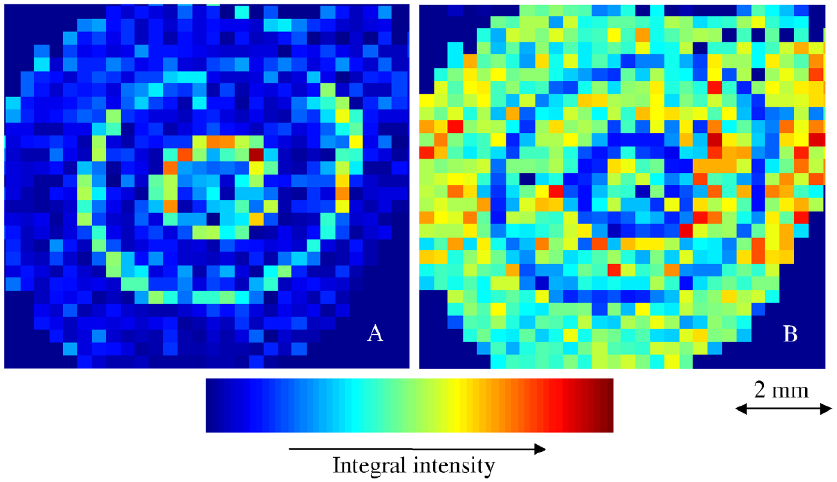
Figure 4. Chemical images of the cross-sectioned urinary stone constructed prior to performing the KKT : A – MIR image of calcium oxalate (C-O) at 1318 cm -1 ); B – MIR image of uric acid (integrated band - n (integrated band - n as oxalate (integrated band - γ (O=C-C=O) at 274 cm -1 ); D – FIR image of uric acid (integrated band - γ (N-H) at 472 cm -1 ). Red represents the highest and blue the smallest concentration.